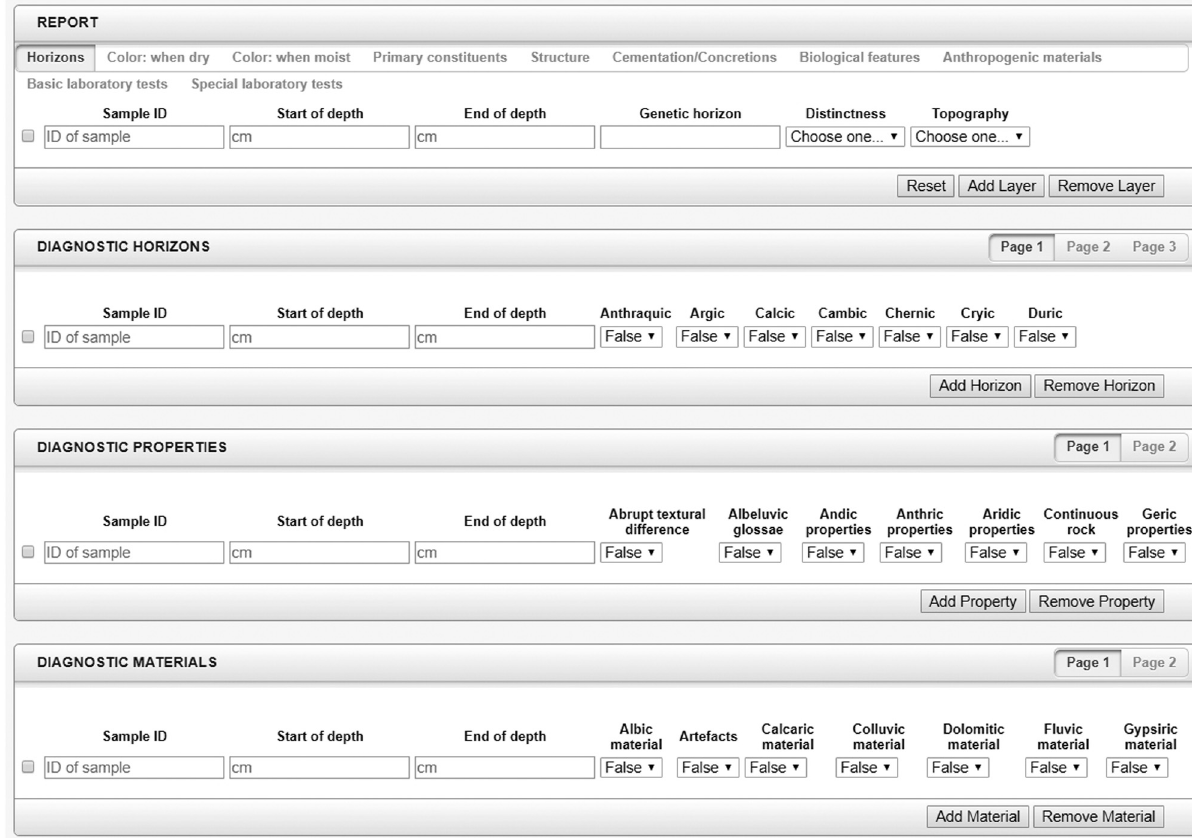
Figure 14: Initializations of layers, genetic and diagnostic